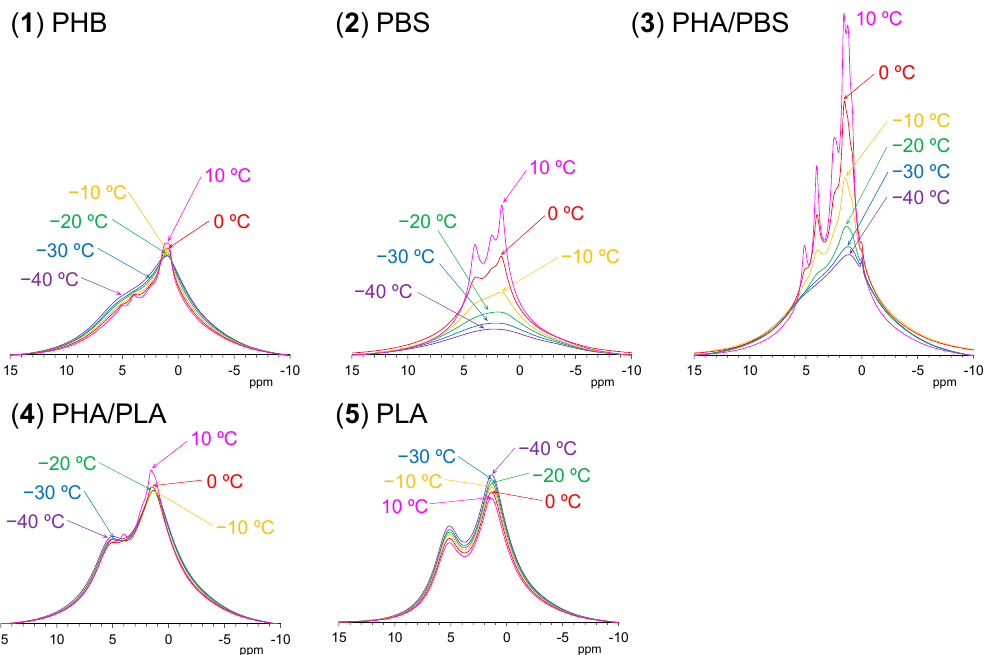
Figure 7. Variable temperature 1 H MAS NMR spectra of plasticized PHA copolymers and constituent polymers. The temperature was increased from 40 °C to − 10 °C.